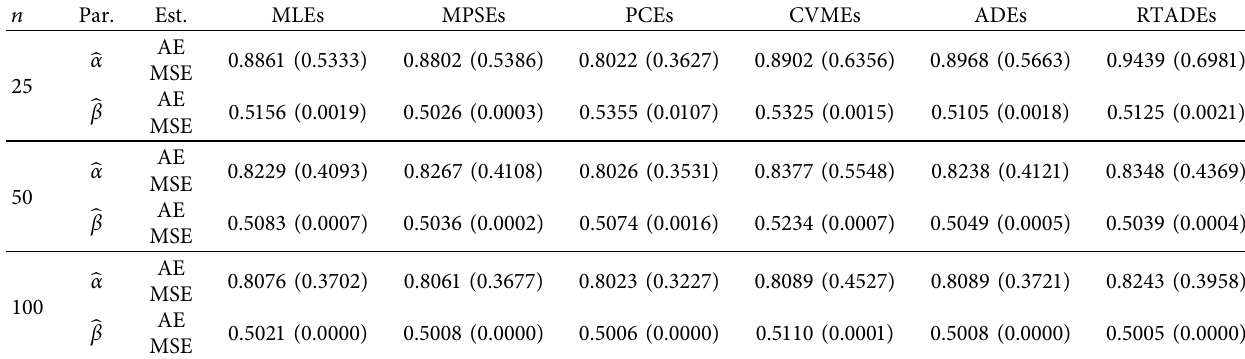
Table 6: The AEs and MSEs for ( α � 0 . 8 and β � 0 . 5 ) T